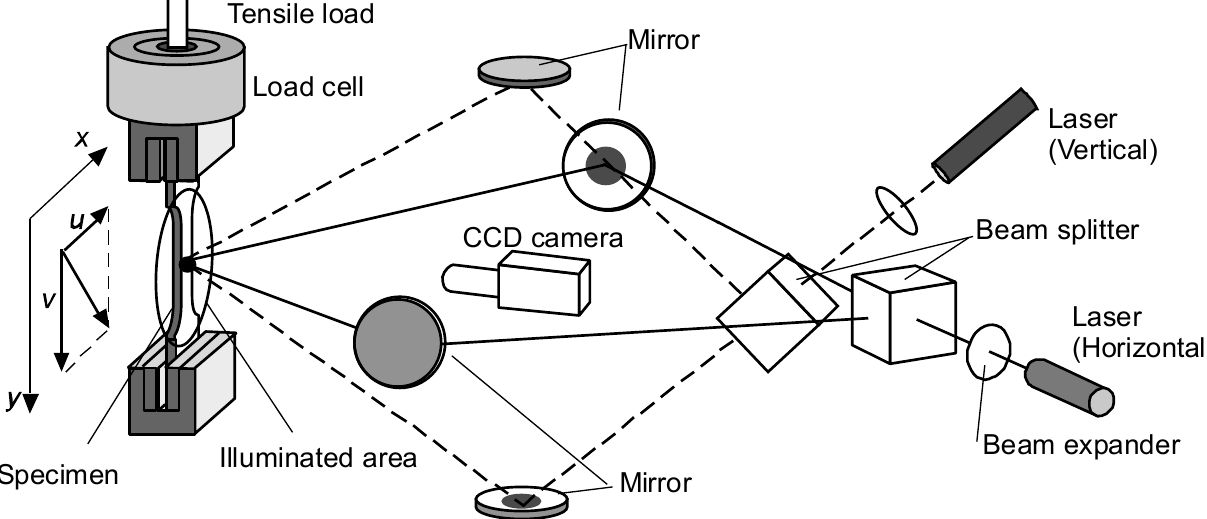
Figure 1. Optical setup of 2-D electronic speckle pattern interferometer [9].